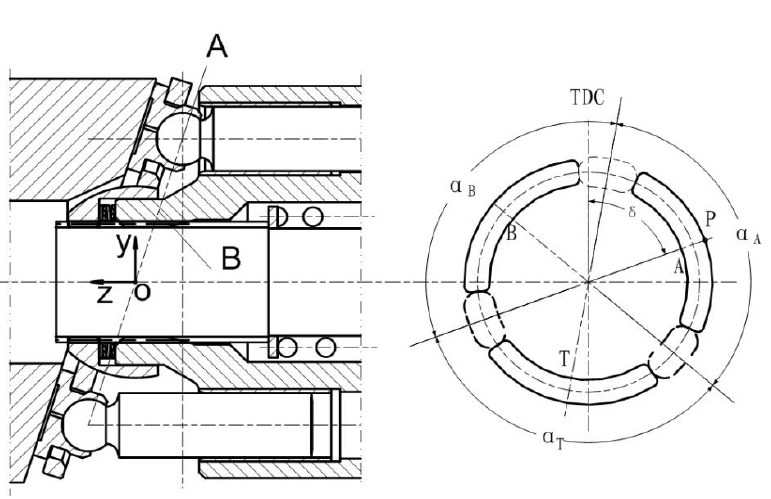
Figure 4. The distribution of the pressure ports on the valve plate.